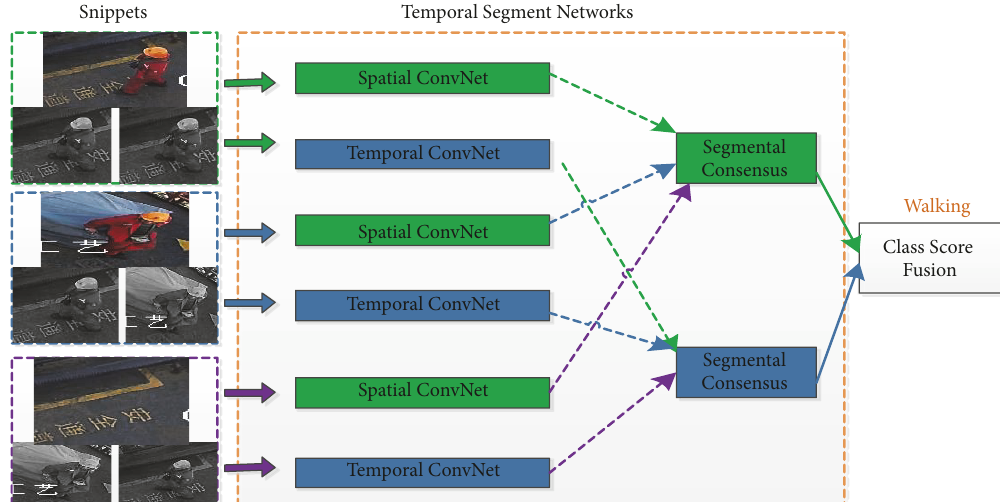
Figure 2: Temporal segment